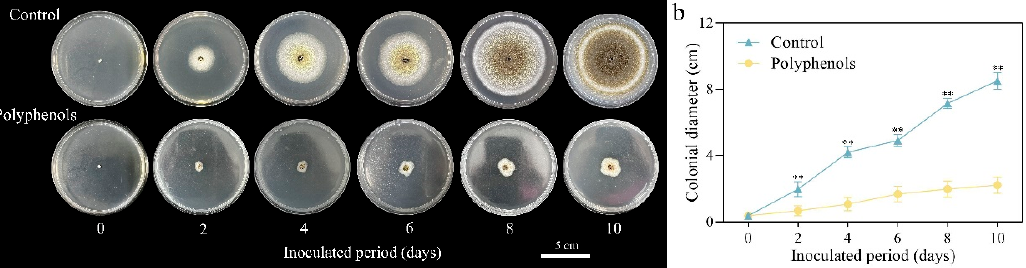
Figure 7. Antibacterial efficacy of herbaceous peony polyphenols on Aspergillus spp. ( a ) The perfor-